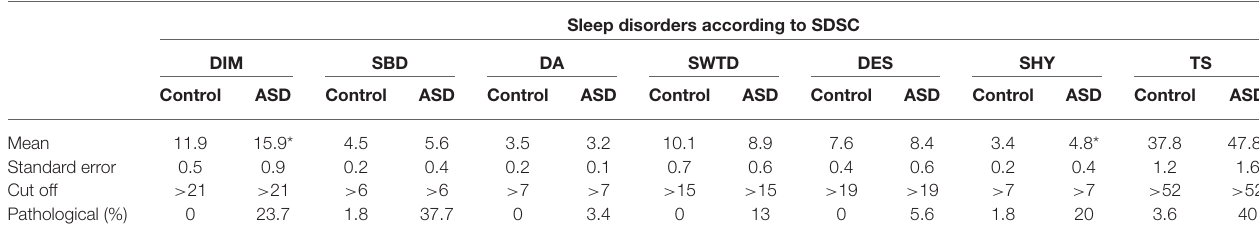
TABLE 1 | Percentage of individuals experiencing sleep disturbances according to Sleep Disturbance Scale for Children (SDSC)